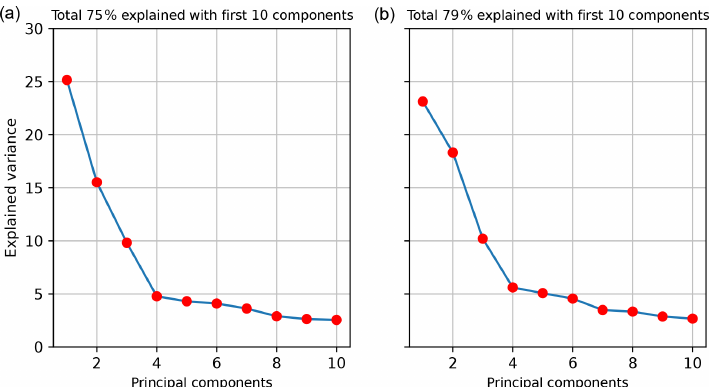
Figure A14. The explained variance of SLP principal components extracted from global DJF SLP fields in the period of 1959–2017 (a)